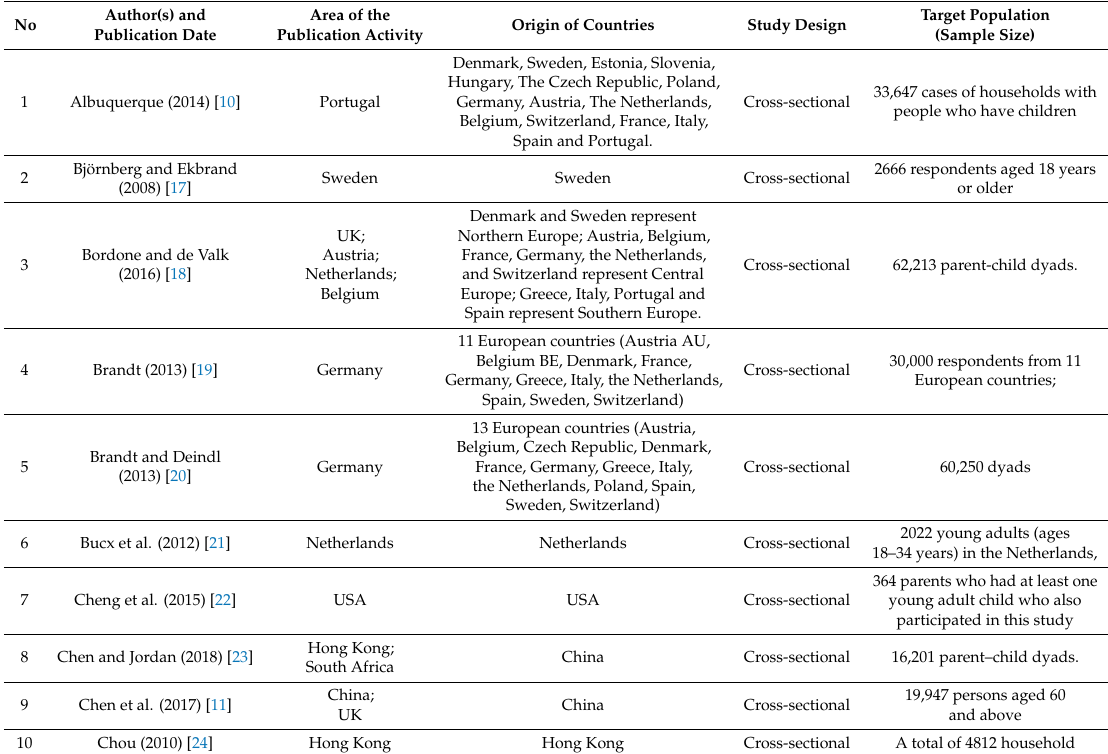
Table 2. Information of 75 included